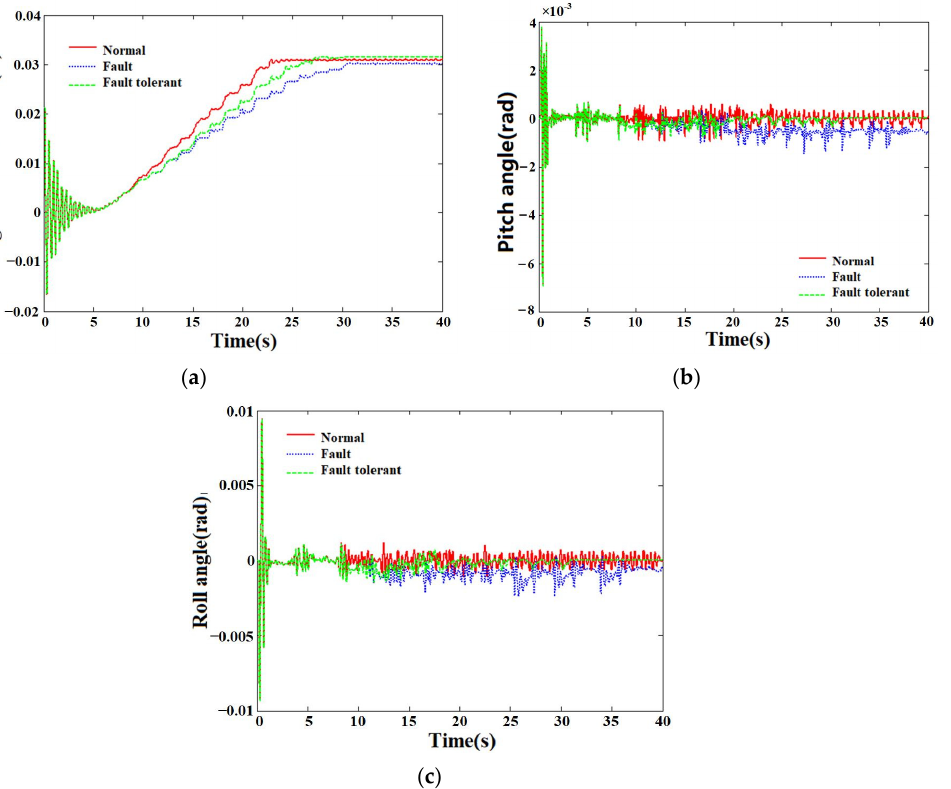
Figure 10. Performance comparison before and after fault tolerant control under Fault 2 (constant gain): ( a ) Relative height of mass center; ( b ) Pitch angle; ( c ) Roll angle.